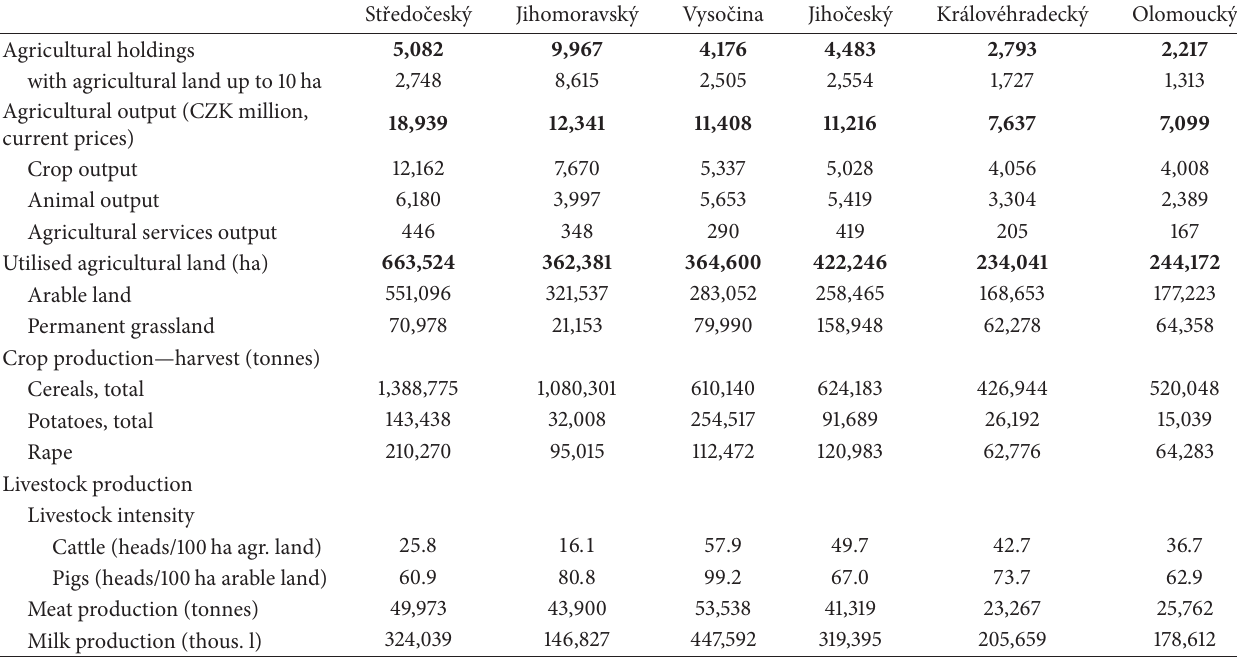
Table 1: Basic characteristic of selected regions in the Czech Republic (2010).